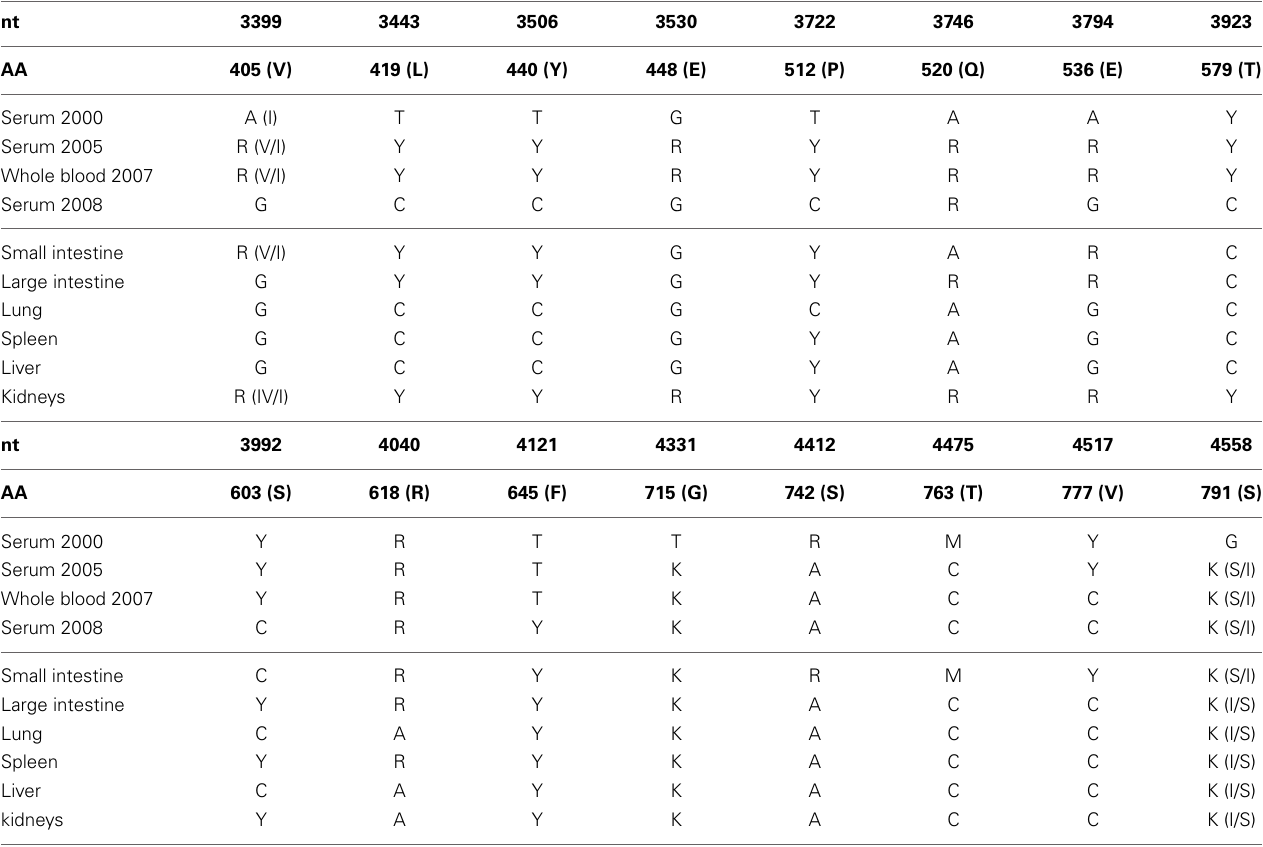
Nucleotide positions refer to the whole genome as reported in GenBank (AN: KP120516); amino acids positions refer to the VP1 ORF. Where the mutation caused an amino acid change the new amino acid is indicated. Polymorphisms are indicated: Y (C or T), R (A or G), K (T or G),M (C or